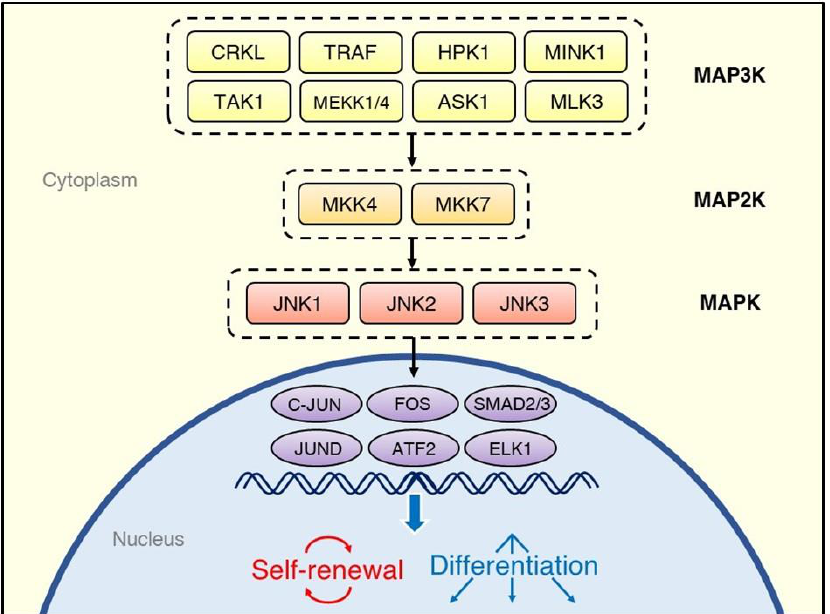
Figure 1. Overview of the regulatory system of the C-JUN N-terminal kinase (JNK) signaling cascade. Various kinds of stimuli, including cytokines, growth factors, and environmental stresses, activate tiers of protein kinases, which phosphorylate JNK isoforms; they, in turn, transduce the signals to transcription factors. The cell fate decisions after activation of the JNK signaling pathway depend on the source of stimulation and type of cells.